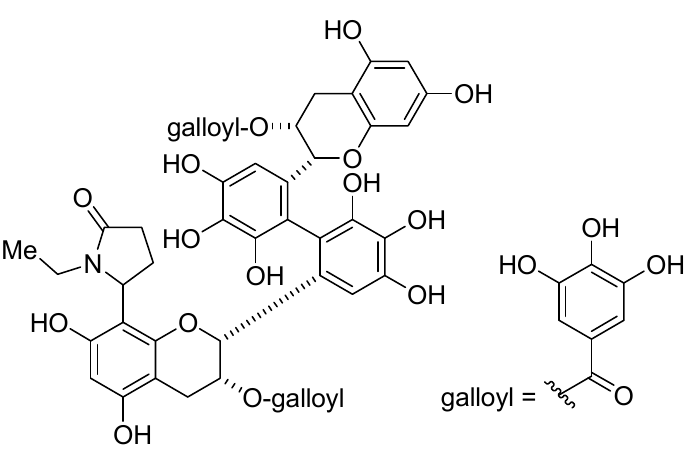
Figure 17. Ethylpyrrolidinonyl theasinensin A ( 44